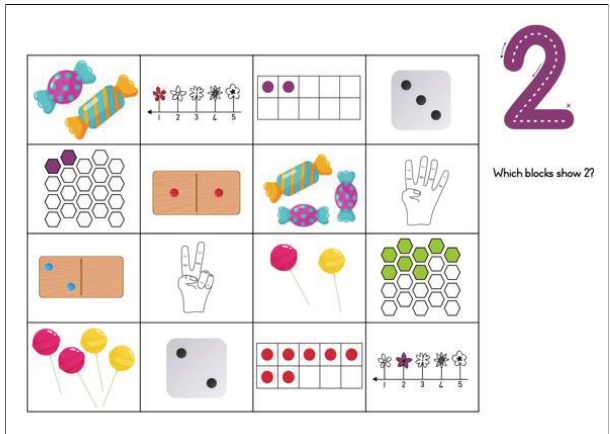
FIGURE 3: Sample of an early number concept activity requiring minimal